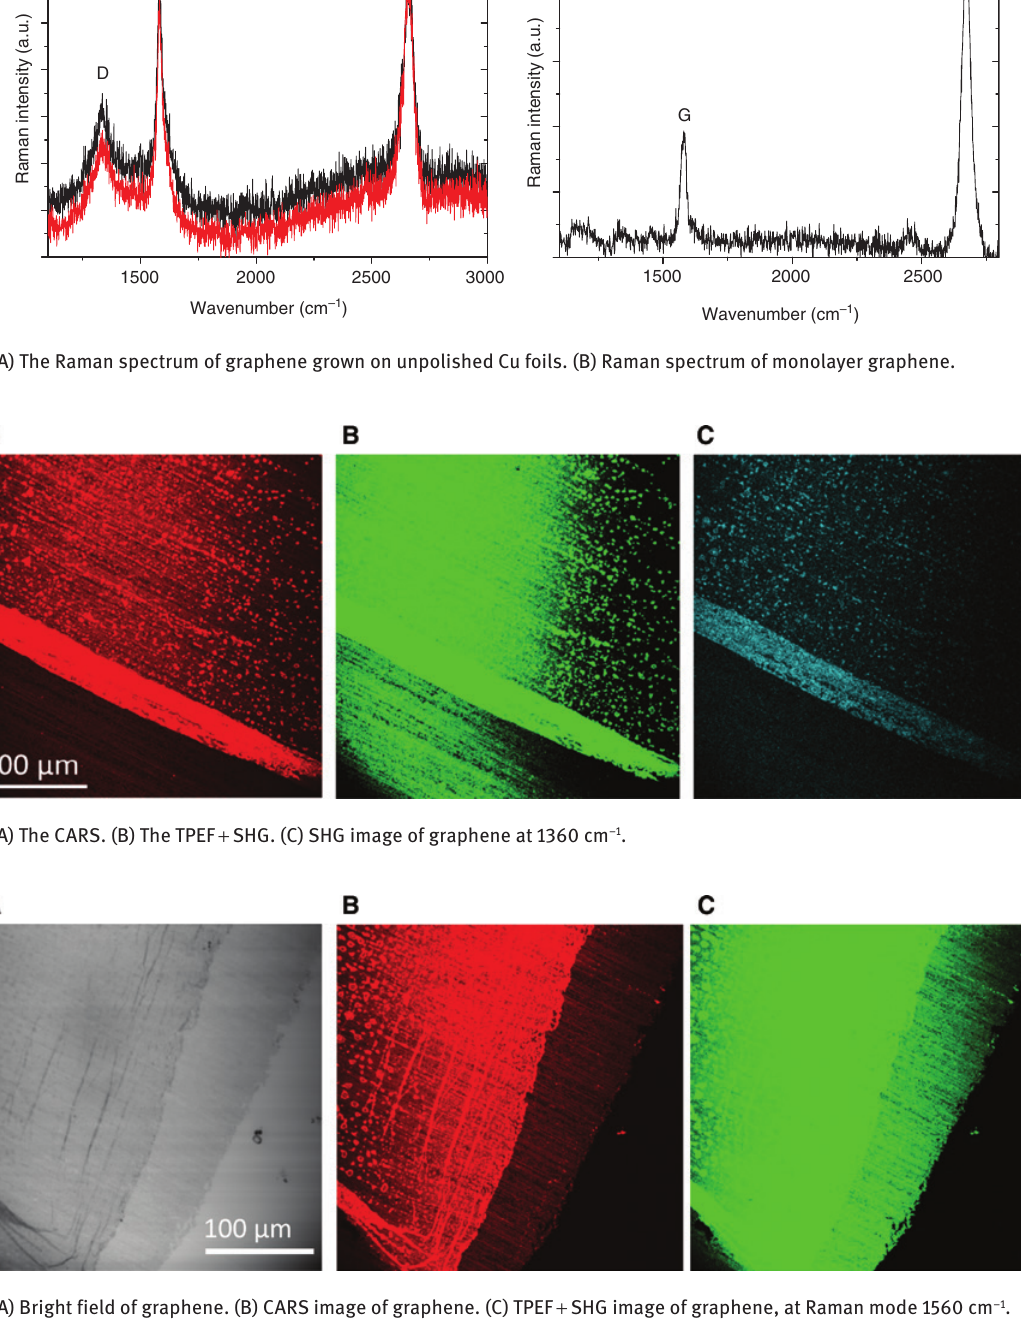
Figure 4: (A) Bright field of graphene. (B) CARS image of graphene. (C) TPEF + SHG image of graphene, at Raman mode 1560 cm −1